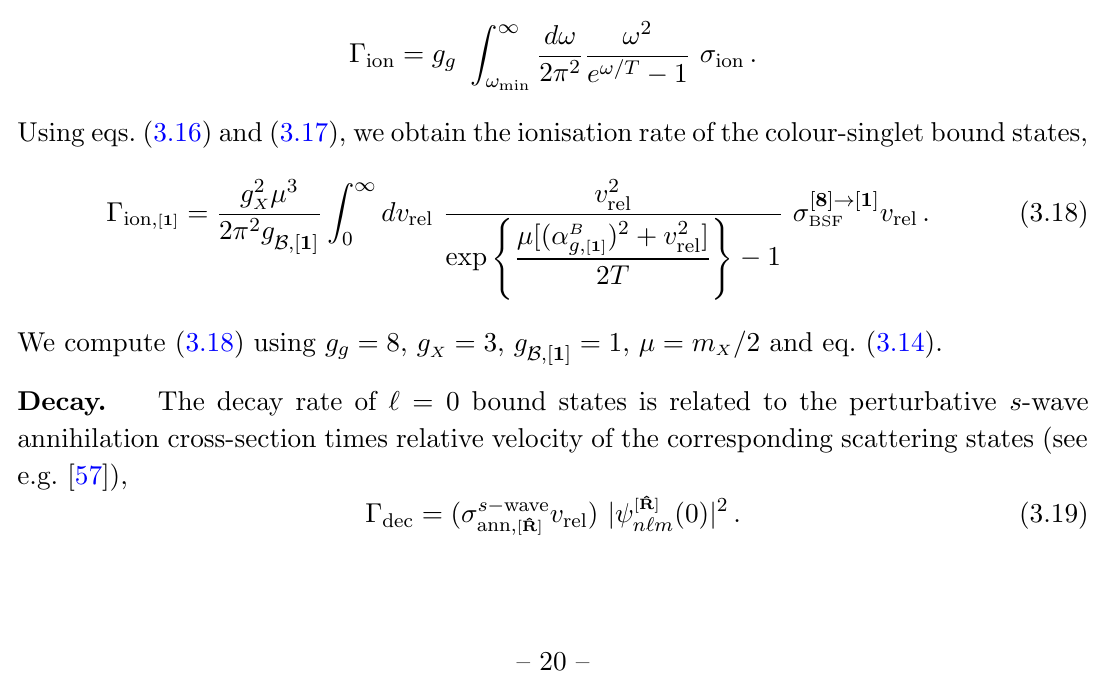
= (27 m 2 ). The blue dashed and blue s X di(cid:11)er due to the running X